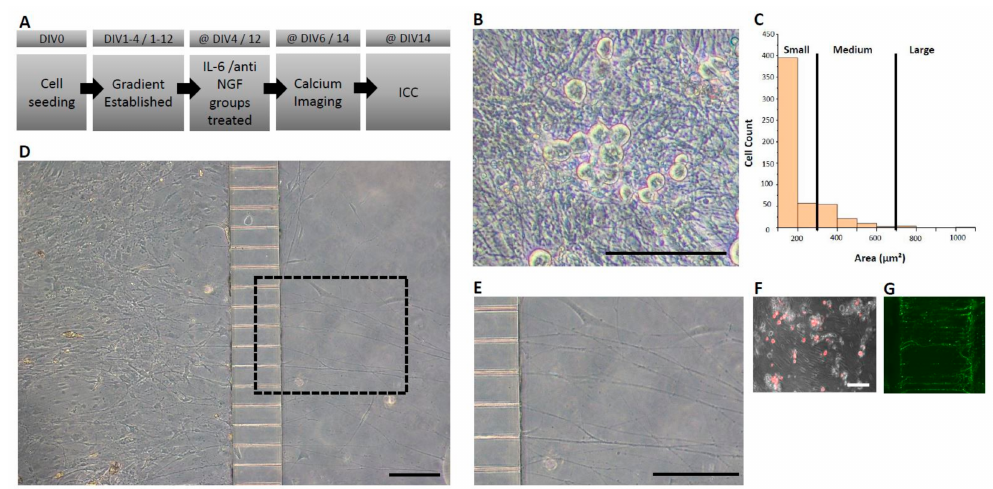
Figure 1. Isolation of axon-like structures in adult mouse DRG neuron cultures in microfluidic- based culture platforms ( A ) Experimental timeline. ( B ) Cell viability observations in phase contrast microscopy depicting healthy neuronal cell bodies. ( C ) Dorsal root ganglia cross-sectional area categorization with the majority of cells being of small-medium range. ( D ) Representative image of a seeded device with the soma (left) and axonal (right) chambers interconnected via microchannels at DIV 6 ( E ) Magnified view of the dashed rectangle from panel D demonstrating isolated axon-like structures crossing microchannels. ( F ) Axon-like structures crossing identified by the fluorescent tracer, Dil, applied to the axonal chamber. Dil is taken up by crossing axons and retrogradely trans- ported to the soma. ( G ) Axon-like structures stained with peripherin, a marker that is preferentially expressed by peripheral sensory neurons. Horizontal scale bars represent 150 µ